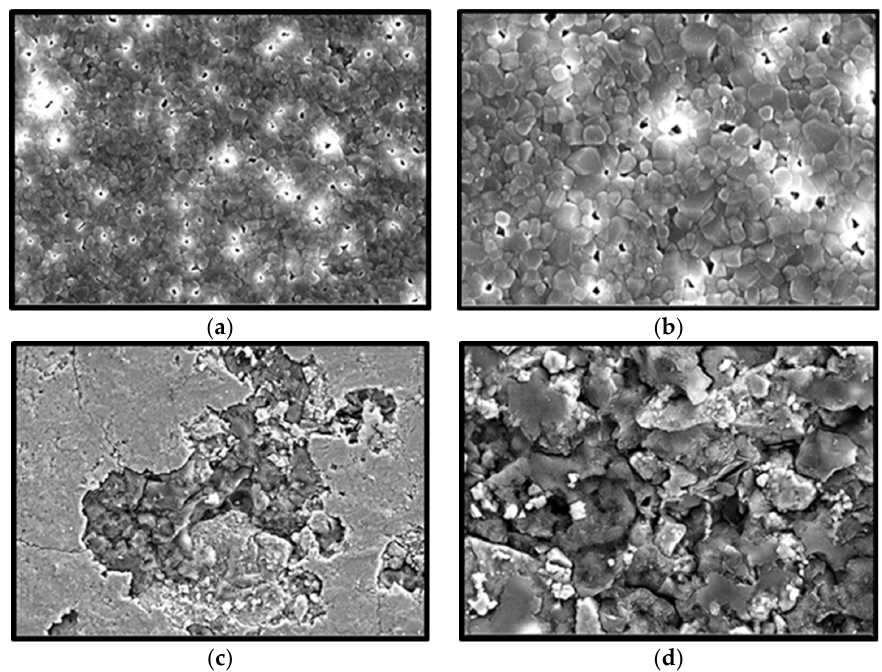
Figure 1. Field emission scanning electron microscopy (FESEM) images of hydroxyapatite scaffolds. Sinter scaffolds ( a ) 100× magnification; ( b ) 1000× magnification. Nonsinter scaffolds ( c ) 100× magnification; ( d ) 1000 ×